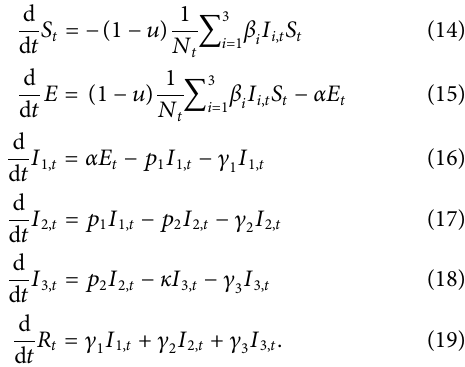
proportions) at time t . The unknown model parameters are η (cid:1) { α , β